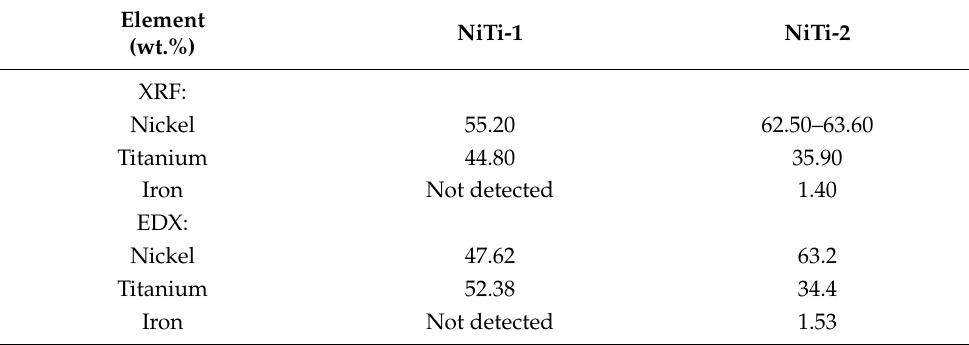
Table 1. Composition of the NiTi-1 and NiTi-2 samples using XRF and EDX analyses.